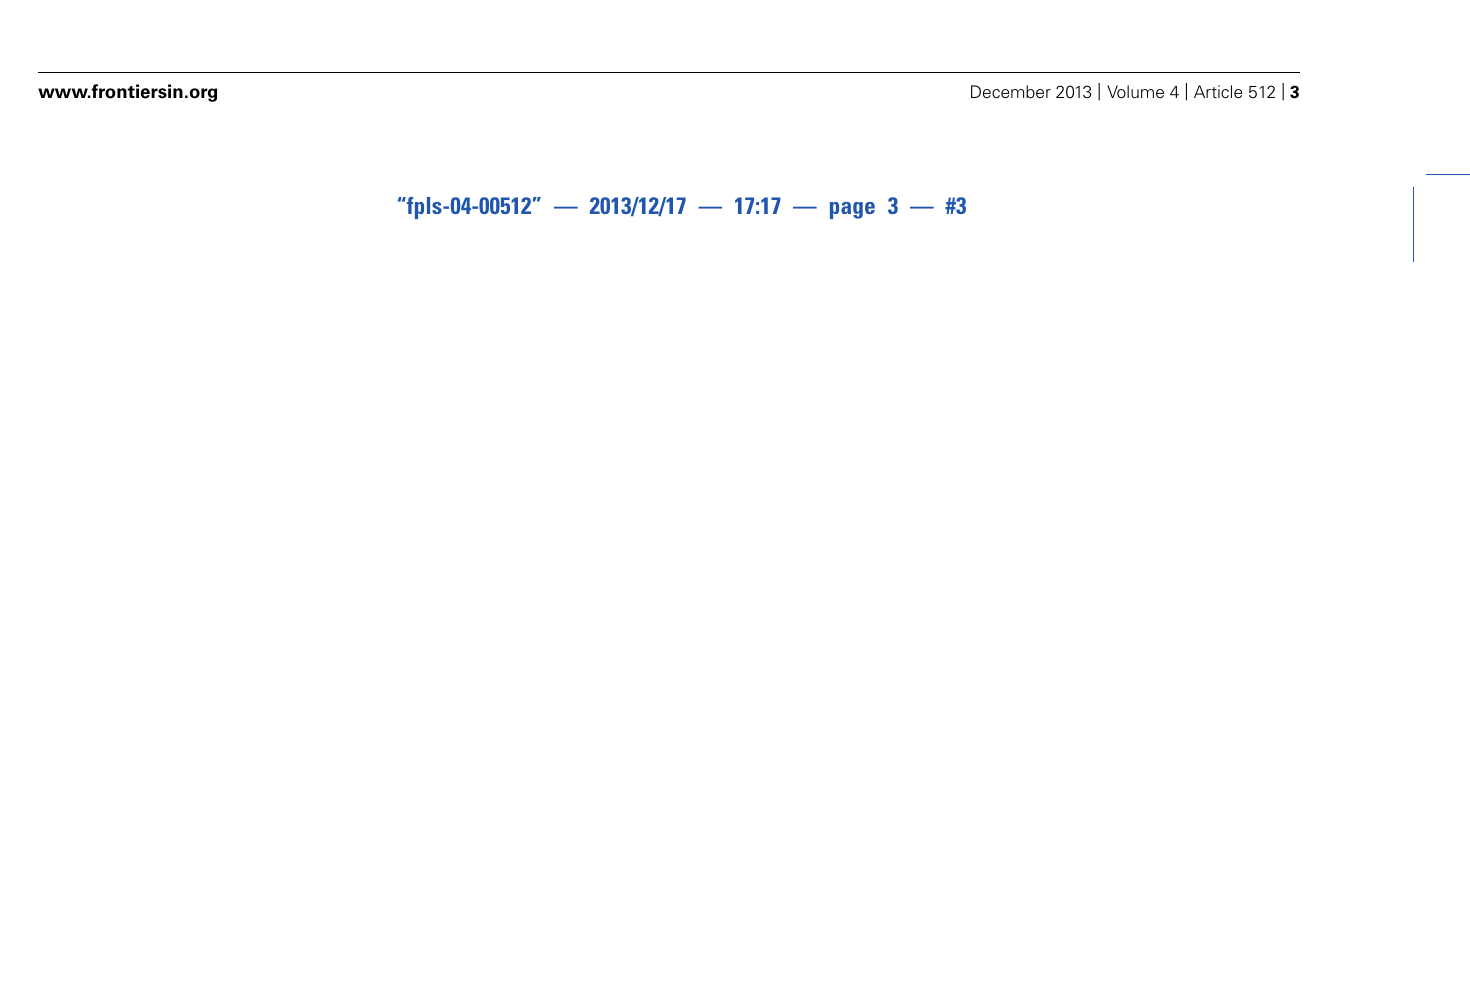
FIGURE 1 |An unrooted phylogenetic tree of profilins. The plant genes are Arabidopsis thaliana AtPRF1–AtPRF5 (AT2G19760, AT4G29350, AT5G56600, AT4G29340, AT2G19770), Petroselinum crispum PcPRF1–PcPRF5 (AY900012-AY900016), Zea mays ZmPRO1–ZmPRO5 (X73279, X73280, X73281, AF032370, AF201459), Oryza sativa OsPRO1–OsPRO2 (LOC_Os10g17680, LOC_Os06g05880), Triticum aestivum TaPRO1–TaPRO3 (X89825-X89827), Nicotiana tabacum NtPRO1 (pronp1 AJ130969), tomato LePRO1 (U50195), Ricinus communis RcPRO1 (AF092547), Phaseolus vulgaris PvPRO1 (CAA57508), Lilium longiflorum LlPRO1 (AF200184).